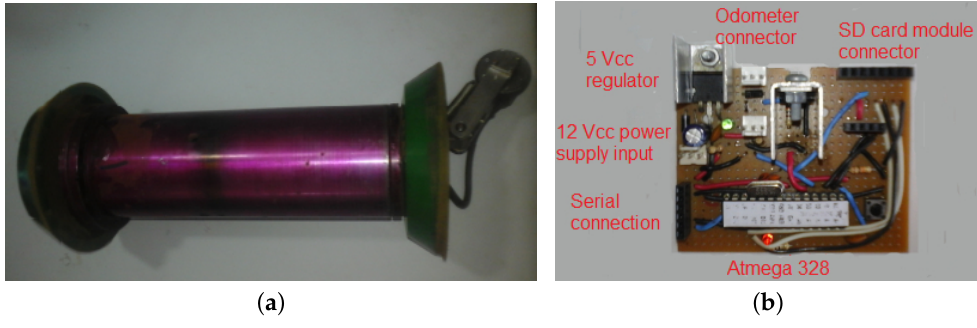
Figure 5. Devices used in this work: ( a ) Prototype PIG; ( b ) Electronic board. Source: By Authors.